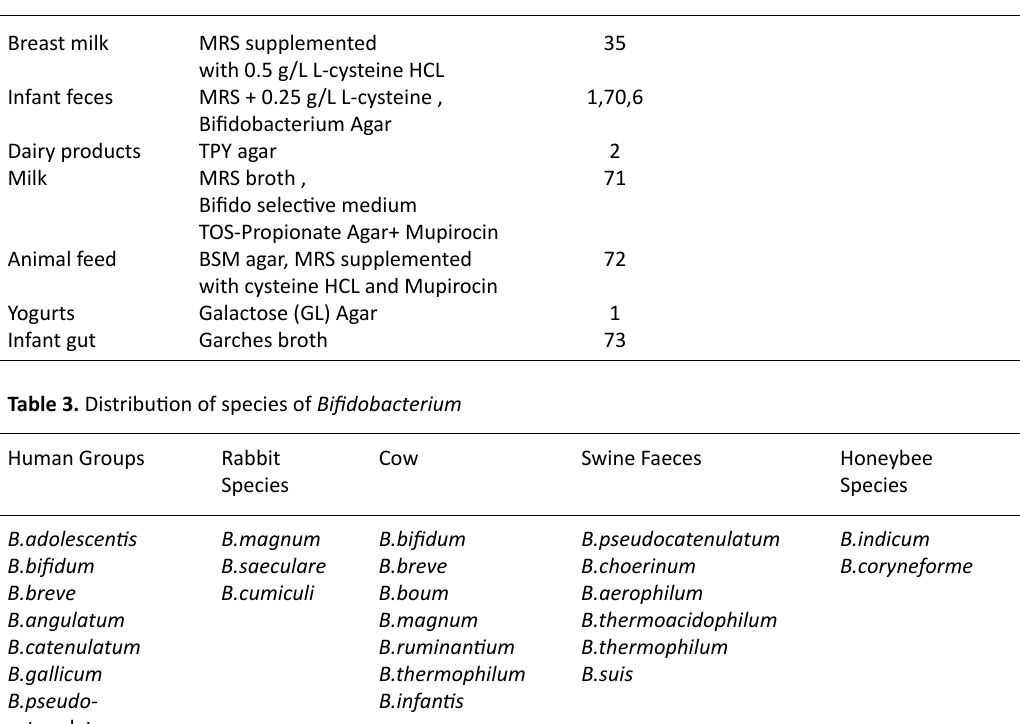
Table 2. Culture medium used in different samples for enumeration of Bifidobacterium sp Sample Type